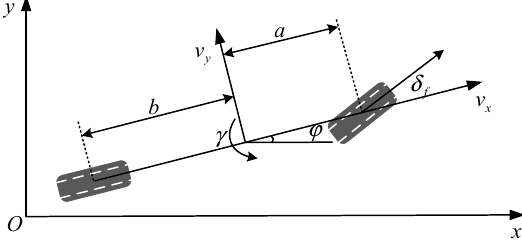
( d ) Figure 2. ( a ) Comparison of different polynomial reference paths; ( b ) Comparison of lateral acceler- ation. ( c ) Comparison of reference yaw rate; ( d ) Lateral reference displacement of fifth order at dif- ferent speeds. The reference transverse angular velocity and lateral acceleration of the fifth polyno-